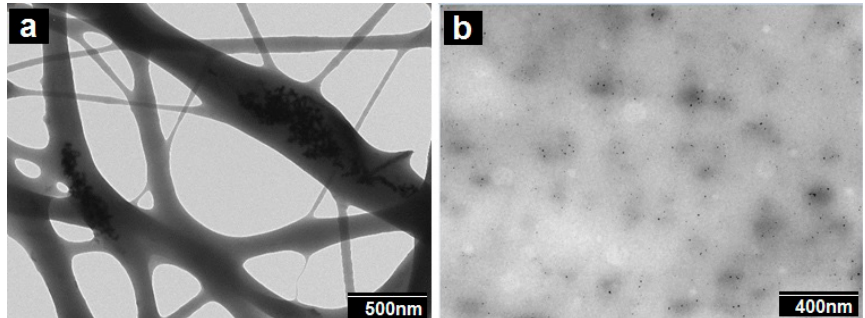
Figure 10. TEM images of ( a ) the PHB/PdNP fibers and ( b ) the PHB/PdNP film.